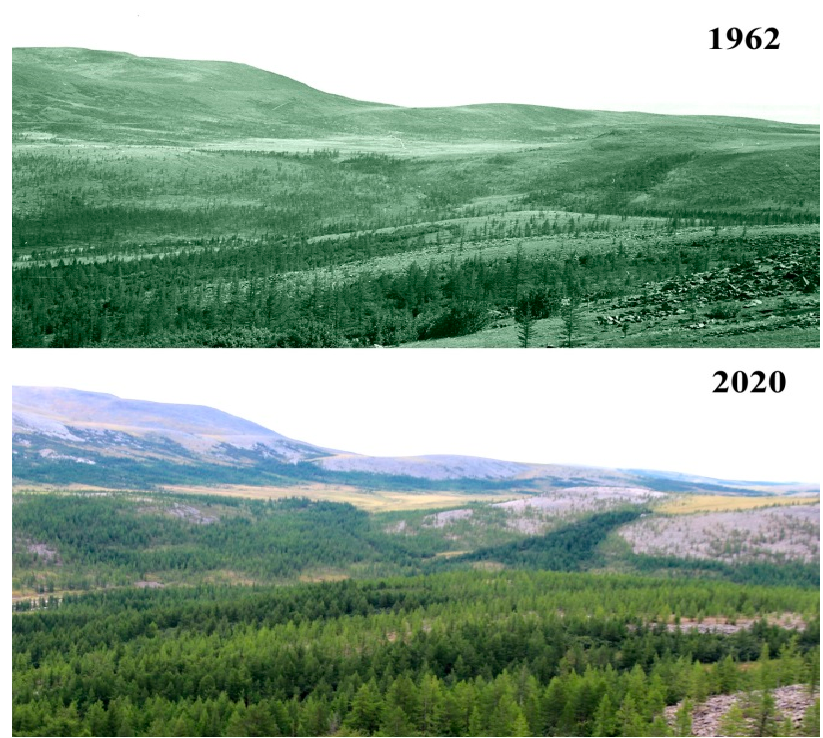
Figure 3. Comparison of the development of vegetation on the Slantsevaya mountain over 58 years (1962–2020) based on photographs. The rise of the upper forest border, and an increase in the tree crown density are evident.